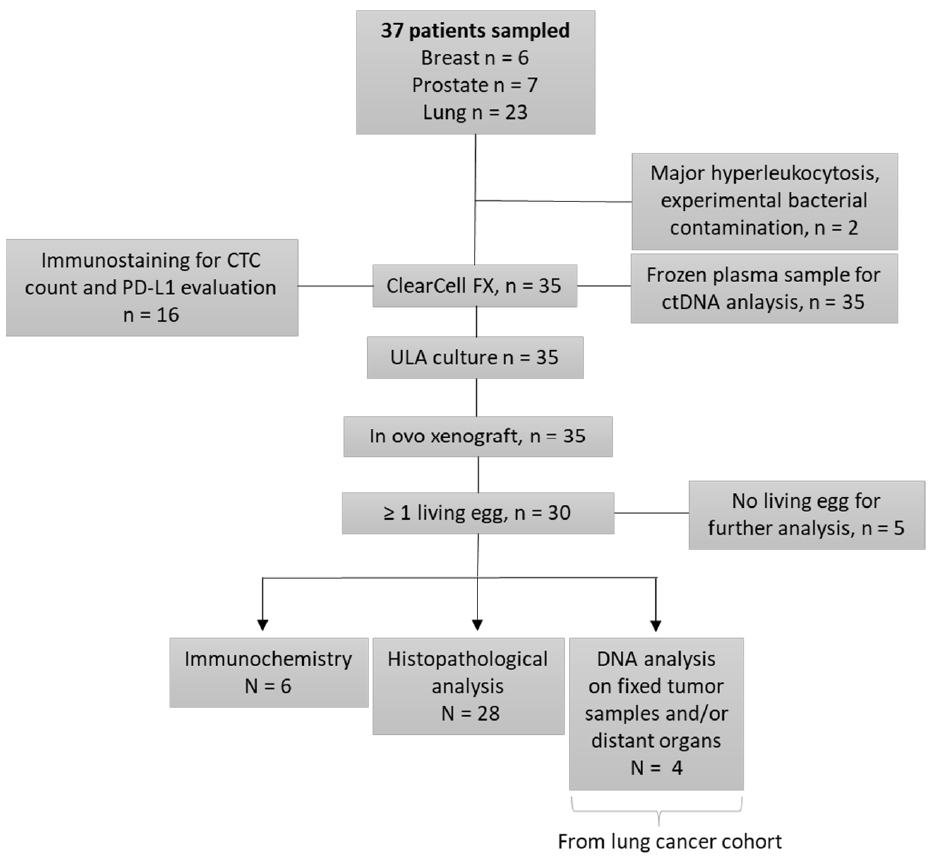
Figure 1. Study Figure 1. Study Flowchart.